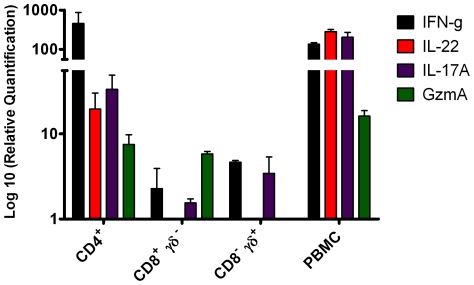
Phenotypic analysis of bovine T cell subsets that expressed the genes encoding for IL22, IL17a and GzmA.Highly purified CD4+, CD8+, and CD8−/TCRδ+ T cell populations were isolated by FACS sorting and the mRNA expression of these genes was determined after stimulation with PPD-B. Results are presented as mean fold increase compared to media control values ± SEM.